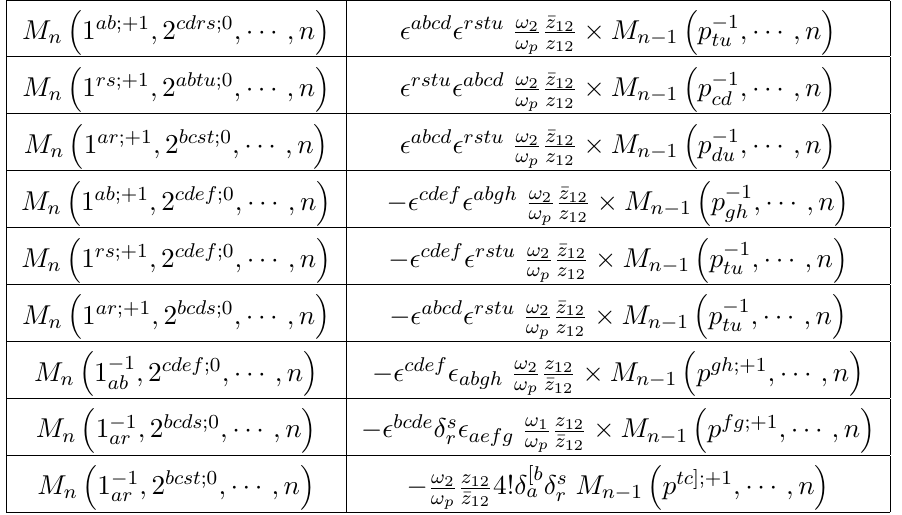
Table 13 . Amplitude corresponding to collinear graviphoton and